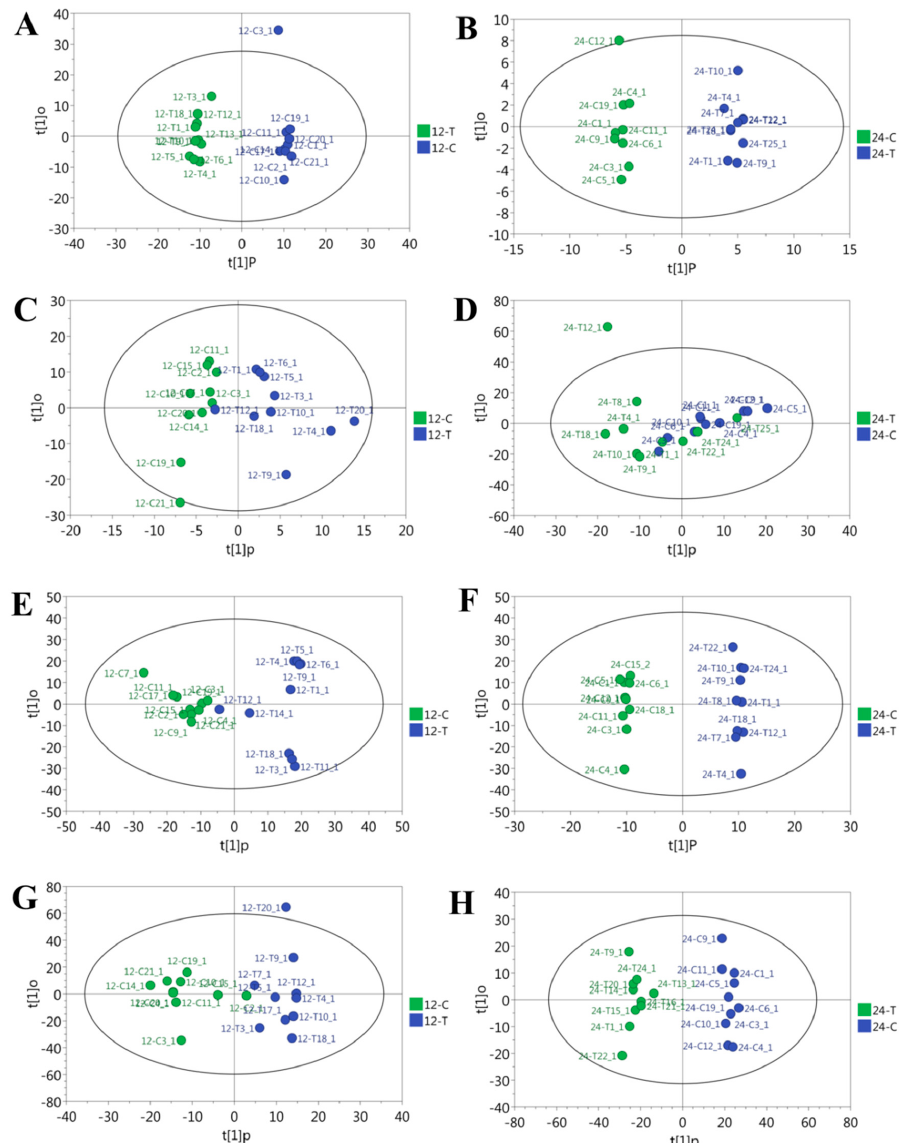
Figure 1. Score plot of orthogonal projections to latent structure–discriminant analyses (OPLS-DA) derived from the GC-TOF-MS profiles of samples obtained from the overfed group (T) vs. the normal control group (C) on day 12 (12-T vs. 12-C) and 24 (24-T vs. 24-C) of overfeeding. The models represent the samples of liver ( A , B ), jejunal ( C , D ), ileal ( E , F ), and cecal ( G , H ) contents, respectively.